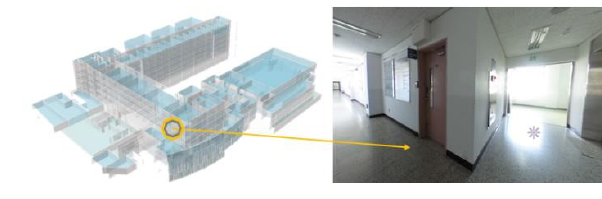
Figure 11. Study Area